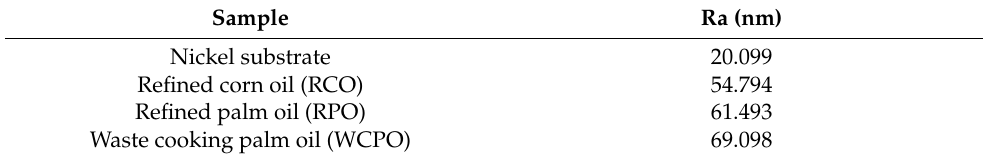
Table 2. The average roughness, Ra, of the graphene growth when different carbon sources are used, and nickel is a substrate [46]. (Adapted with permission from ref. [46]. Copyright 2018 AIP